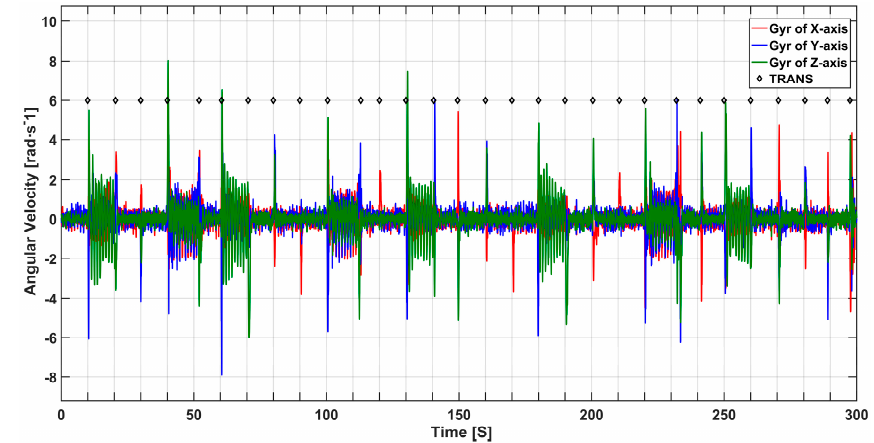
Figure 5. Characteristics of angular velocity during attitude switching in the time–frequency domain.